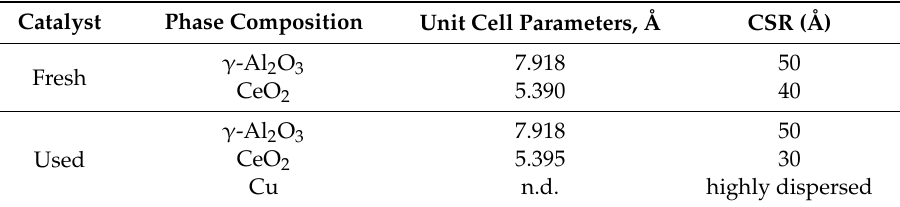
Table 1. XRD data for the CuO-CeO 2 / γ -Al 2 O 3